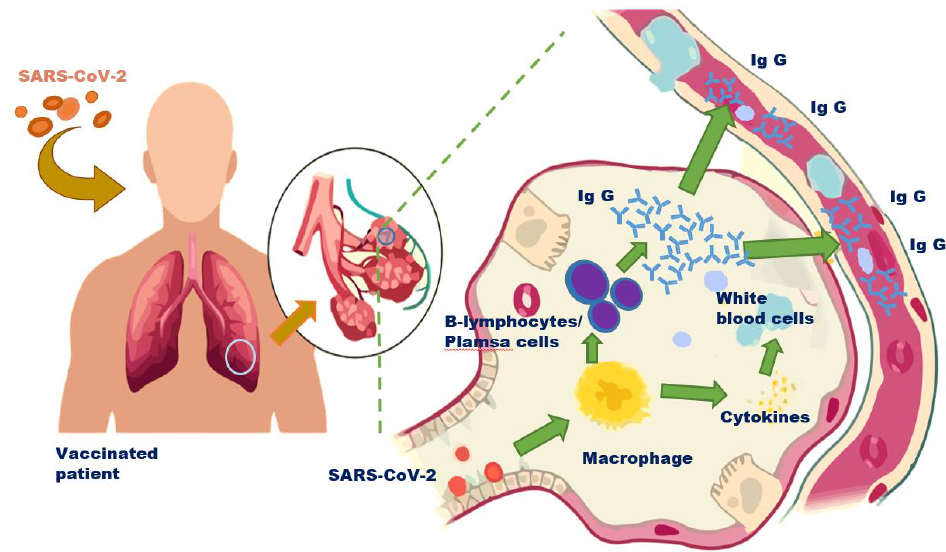
Figure 2. Immune response and IgG antibodies against SARS-CoV-2 reduced in waning fully vaccinated patient or patient with immunosenescence.